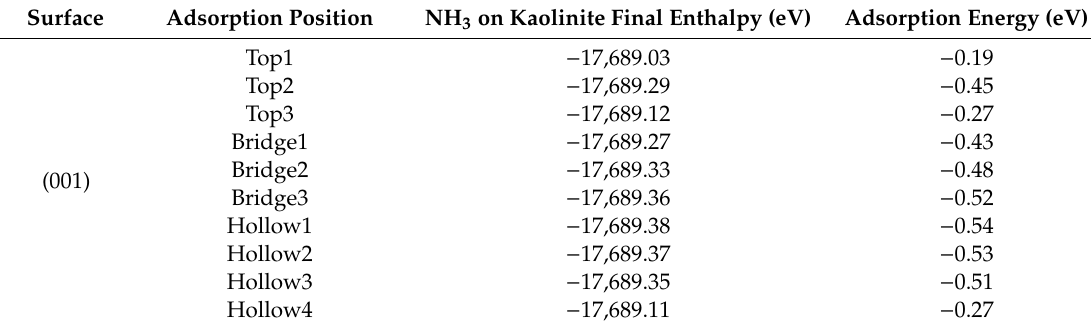
Table 2. Summary of NH 3 adsorption energy corresponding to di ff erent adsorption positions on kaolinite